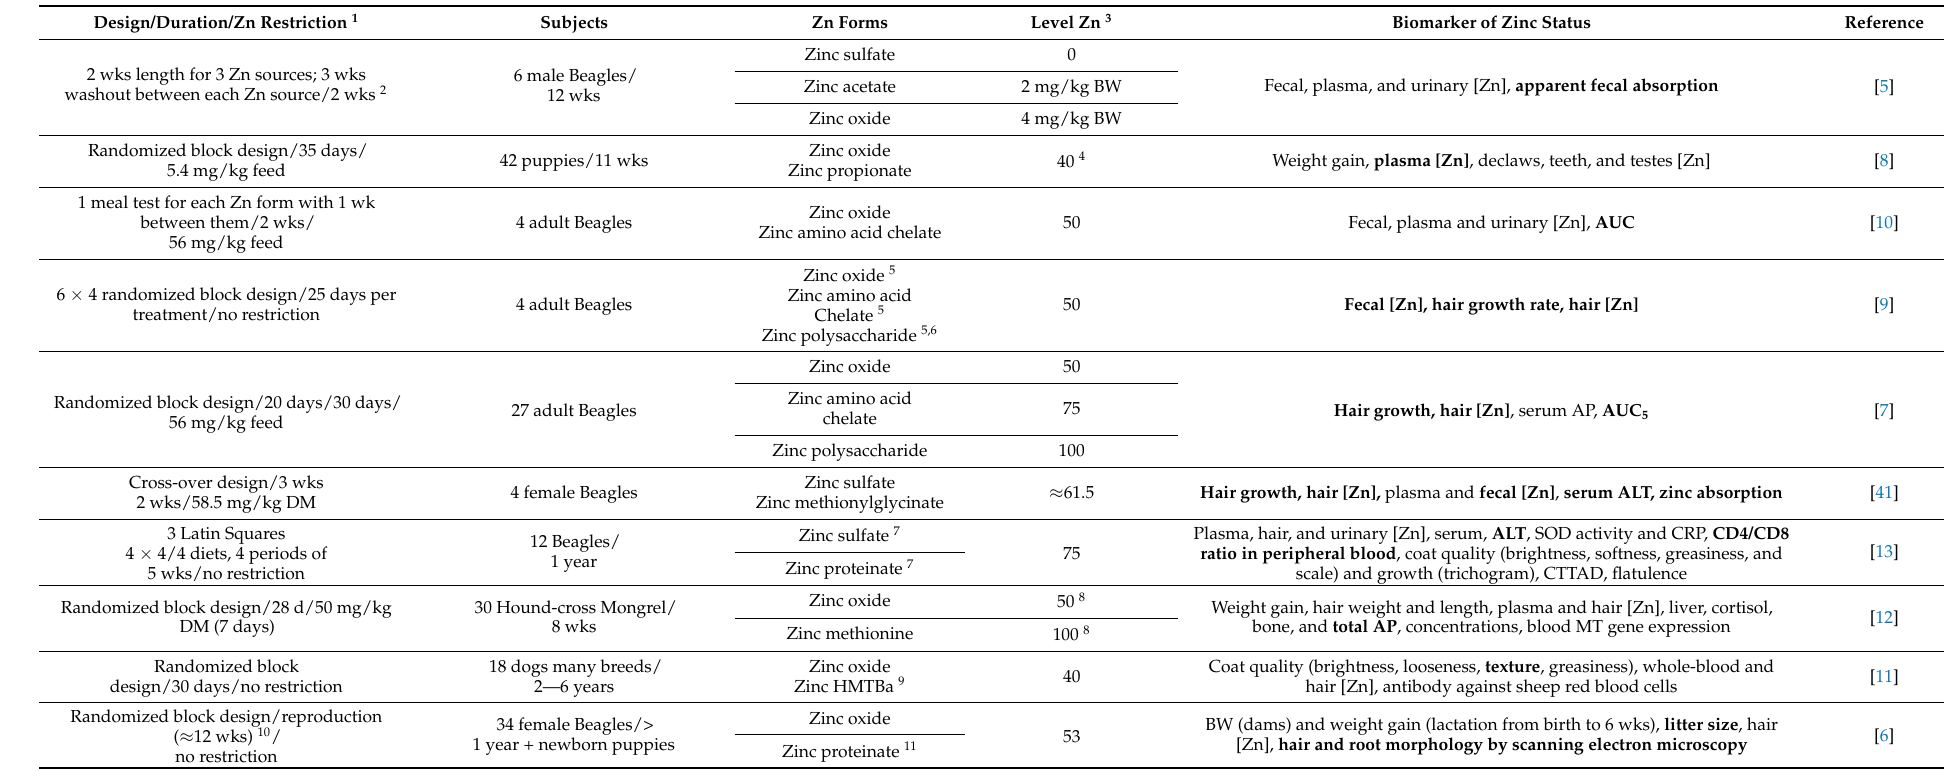
Table 3. Studies of zinc source supplementation in dog